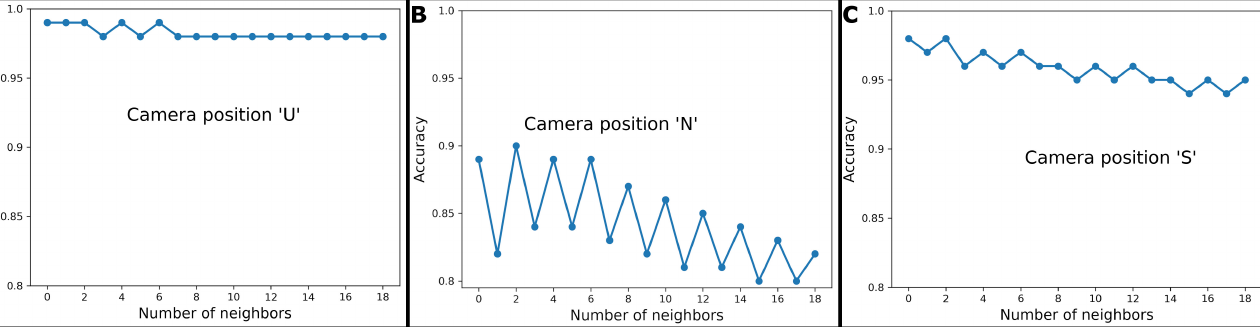
Figure 4. Accuracy depending on the number of neighbours in training a kNN classifier for camera positions ‘U’ (figure part A ), ‘N’ (figure part B ) and ‘S’ (figure part C ). The hyperparameter k was tuned via grid search with five fold cross-validation.